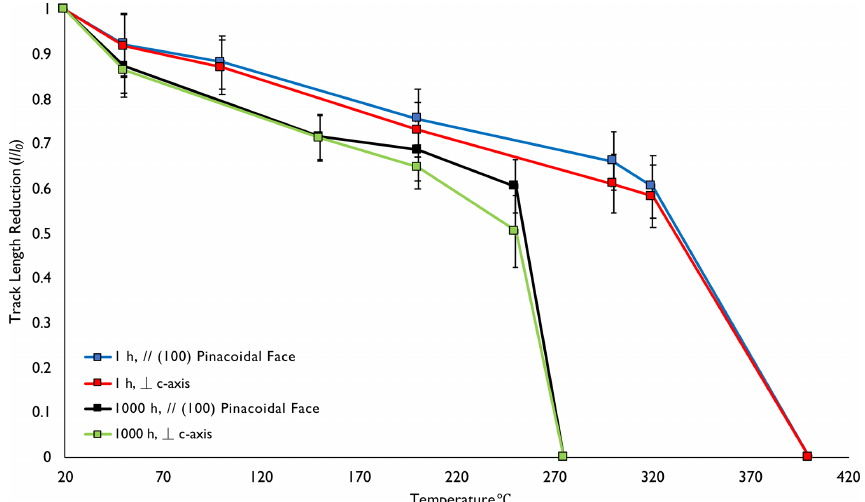
Figure 5. Normalized track length reduction ( l/l 0 ) against temperature for calculated equivalent confined fission tracks for 1 and 1000h experiments for both surface orientations (// and ⊥ surfaces, as in Fig. 4). The normalized track length ( l/l 0 ) values are calculated from the average length of the control samples (10.60µm). Error bars refers to 1 σ errors.